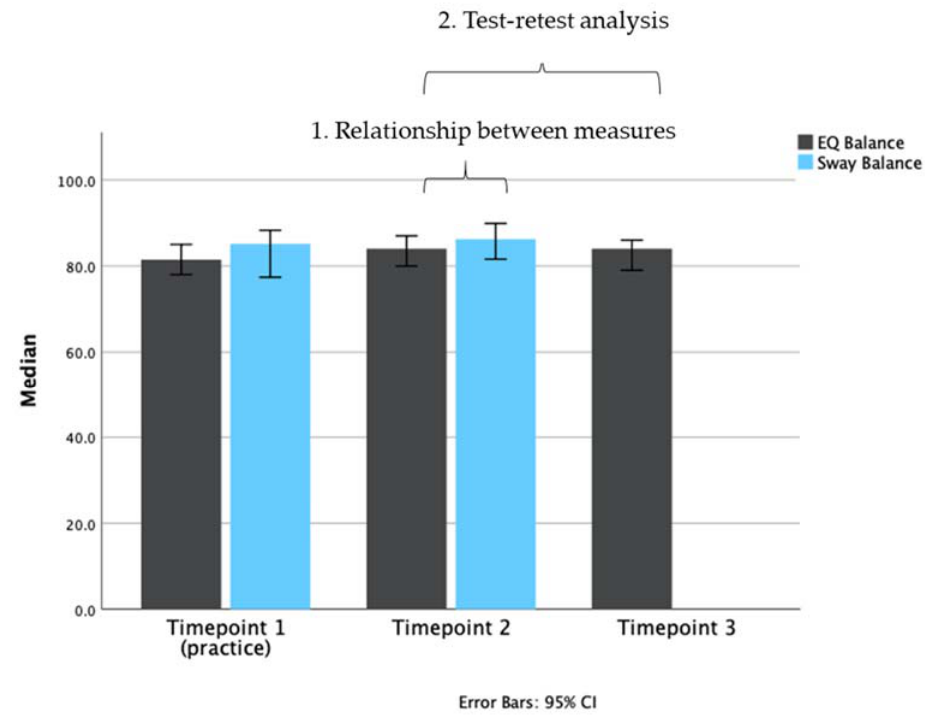
Figure 3. Bar plot representing the median scores of each test (EQ Balance, gray bars; Sway Balance, blue bars) at di ff erent time points. Timepoint 1 (T1) was used as a practice / acclimatization session. Timepoint 2 (T2) was the main test session. Timepoint 3 (T3) was used in the test-retest analysis for EQ Balance. Data are plotted as medians with 95% confidence intervals.